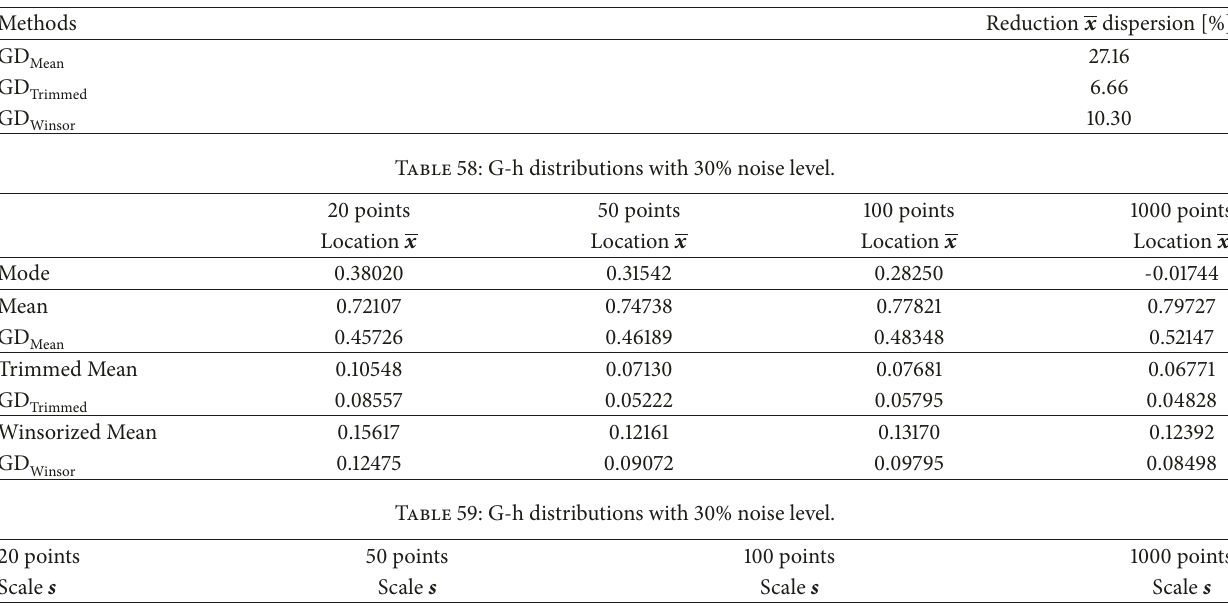
Table 57: Contaminated 𝜒 2 with 1000 points.